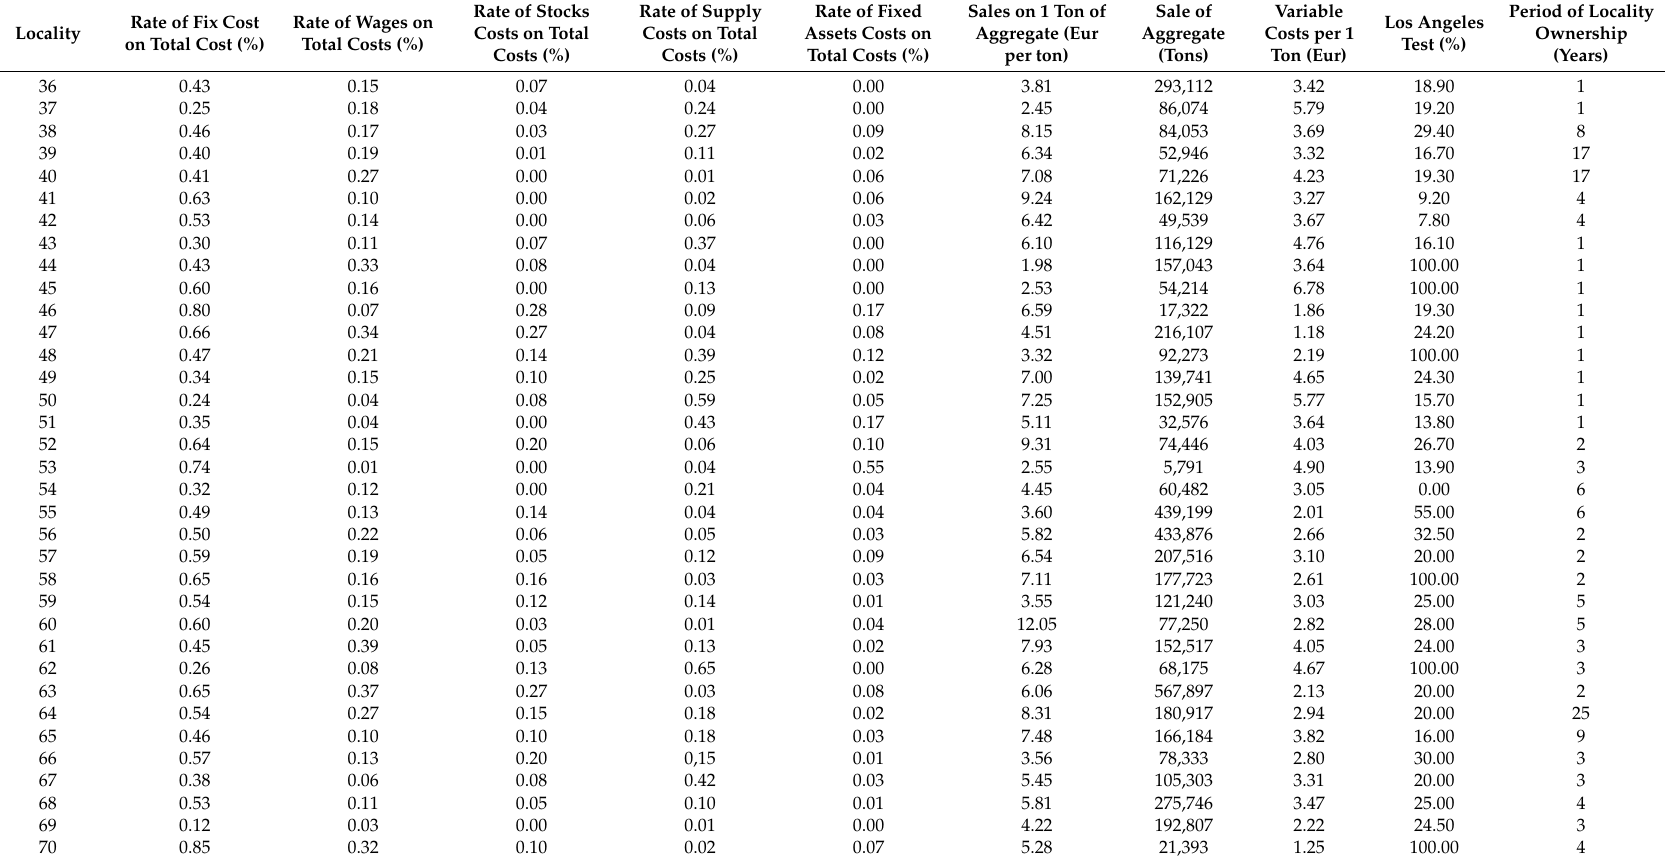
Table 2. Input table for unprofitable